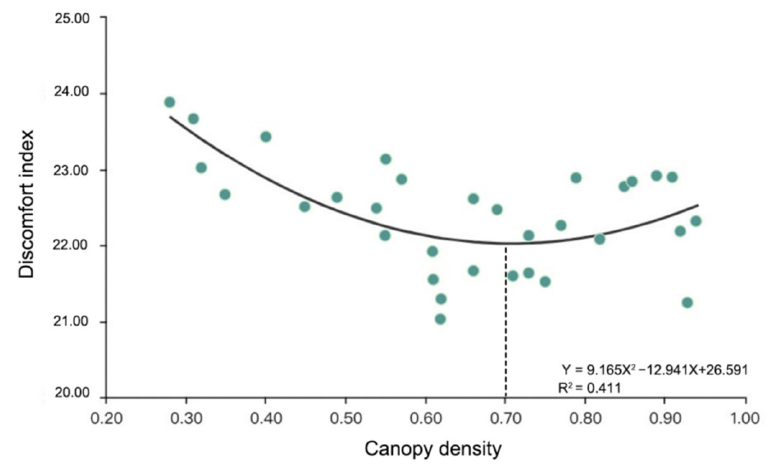
Figure 7. Relationship between discomfort index and canopy density.